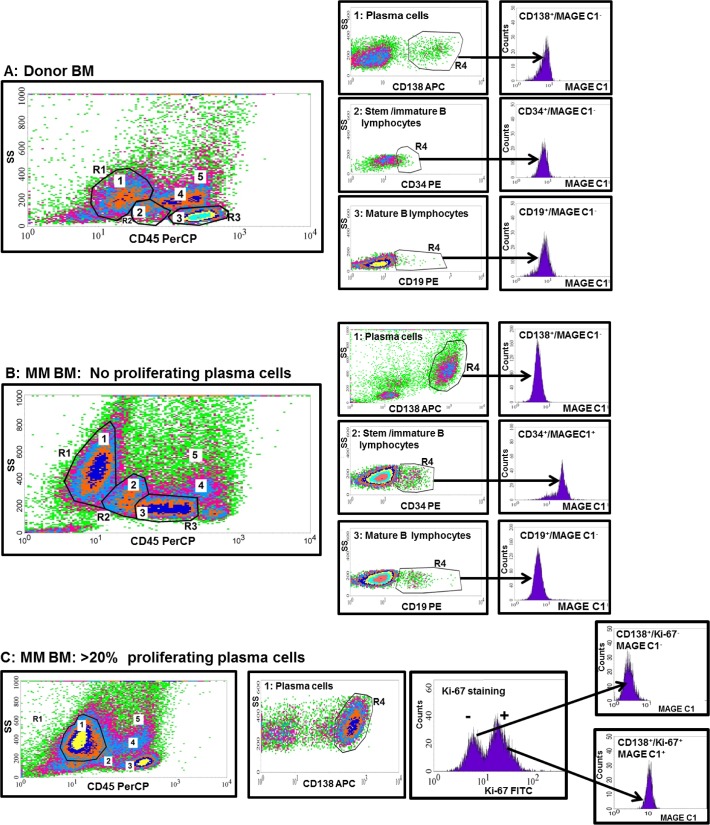
Examples of flow cytometric analysis of the BM of a donor (A) and two MM patients (B and C) to determine the different B cell lineage cell populations expressing MAGE C1.Mononuclear cells from donor and MM patient BM were stained with different antibodies to determine the cell phenotype and stage of B cell maturation where MAGE C1 was expressed. A and B: Density plots (SS and CD45) were used to selectively gate around specific cell populations including plasma cells (R1), stem/immature B lymphocytes (R2) and mature B lymphocytes (R3). Using various antibodies specific to the cells of interest gated in R1, R2 and R3, cells with positive antibody expression were further selectively gated (R4) and MAGE C1 expression was determined with histograms. A: Donor BM indicated that all selected cell populations were negative for MAGE C1 expression. B: MAGE C1 expression was observed in the stem/immature B lymphocytes and not in the non-proliferating plasma or mature B lymphocytes of the MM patient. C: Density plots (SS and CD45) were used to selectively gate the plasma cells (R1) and these cells were further confirmed with CD138 (R2). The proliferation index of the plasma cells was determined with Ki-67 expression and this was correlated to MAGE C1 expression via histograms, respectively. MAGE C1 expression was only observed in the proliferating plasma cells (Ki-67>20%). 1: Plasma cells, 2: Stem/immature B lymphocytes, 3: Lymphocytes, 4: Residual monocytes, 5: Residual Granulocytes.